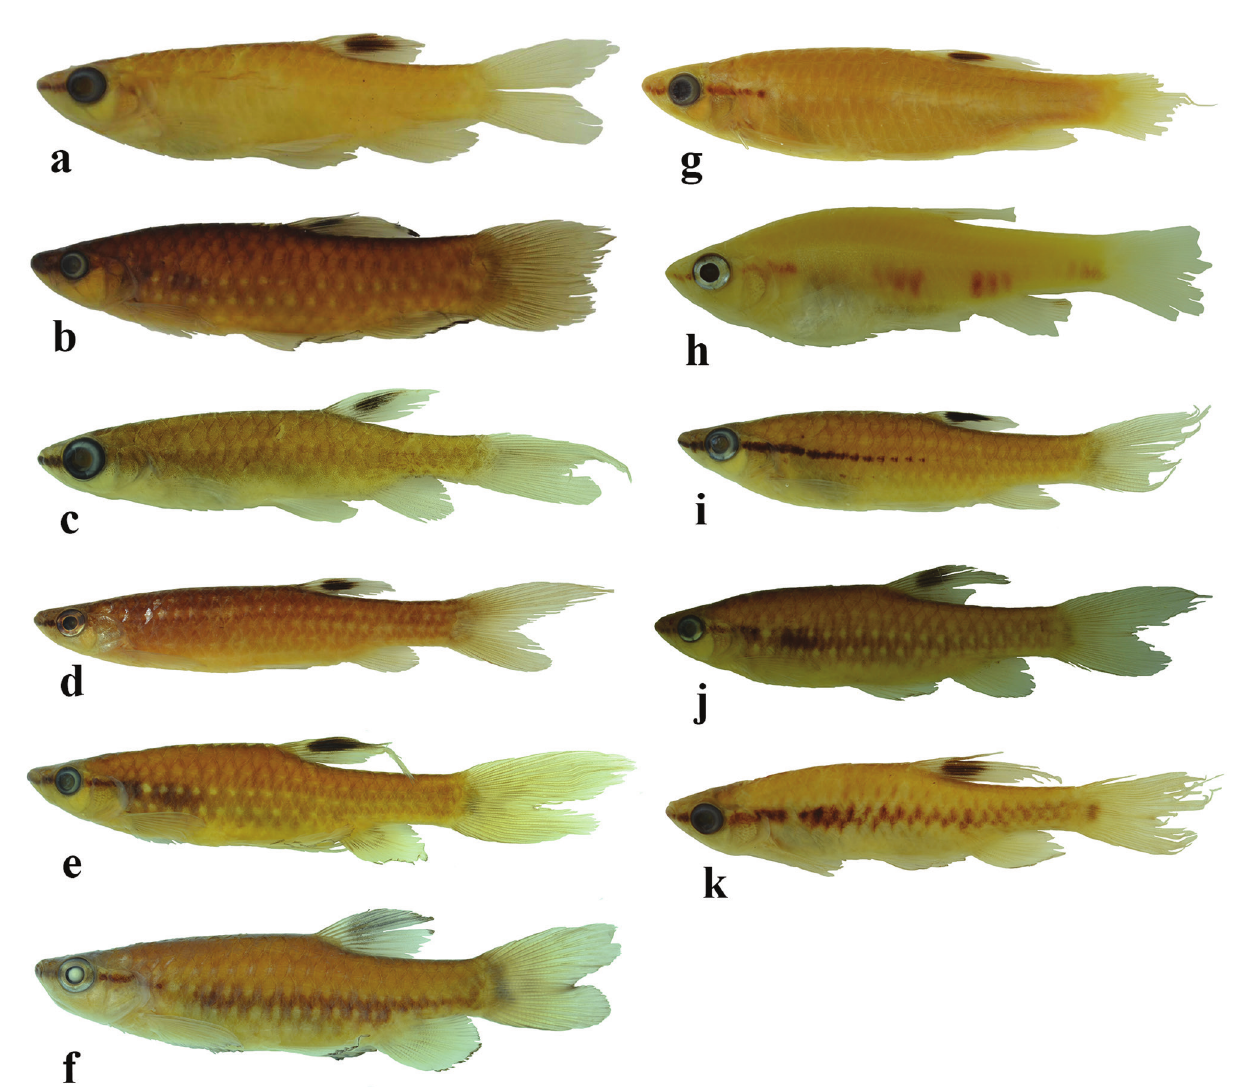
Fig. 2. Lateral view of: a. Pyrrhulina australis , MCP 39259, 38.8 mm SL, male, Poconé, Mato Grosso, Brazil; b. Pyrrhulina brevis , INPA 27819, 56.3 mm SL, male, Manaus, Amazonas, Brazil; c. Pyrrhulina elongata , MPEG 26568, 30.6 mm SL, male, Rio Tapajós, Pará, Brazil; d. Pyrrhulina filamentosa , MHNLS 14282, 59.5 mm SL, female, Essequibo River, Guiana; e. Pyrrhulina eleanorae , FMNH 113654, 39.7 mm SL, male, Rio Napo, Ecuador; f. Pyrrhulina obermulleri , ANSP 152043, 37.2 mm SL, male, Maynas, Peru; g. Pyrrhulina stoli , USNM 66254, 60.8 mm SL, female, upper Potaro river, Guyana; h. Pyrrhulina spilota , USNM 197523, 52.7 mm SL, male, Loreto, Peru; i. Pyrrhulina semifasciata , MCP 37466, 56.7 mm SL, female, Loreto, Peru; j. Pyrrhulina cf. maxima , MPEG 19120, 50.4 mm SL, male, Rio Amazonas, Brazil; k. Pyrrhulina zigzag , FMNH 94556, 35.6 mm SL, male, Rio Napo, Description. Morphometric data of the holotype and 60 paratypes presented in Tab. 1. Lateral view of male holotype and female paratype in Fig. 1a and Fig. 1b, respectively.